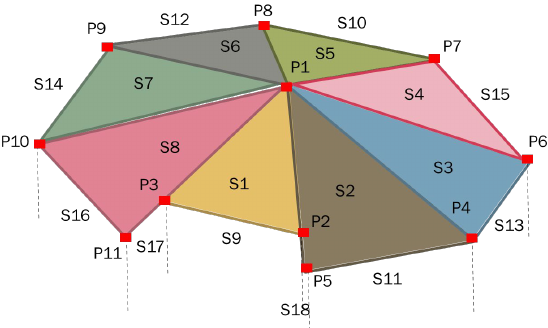
Figure 11. Schema of vertexes and surfaces for Scenario 3.